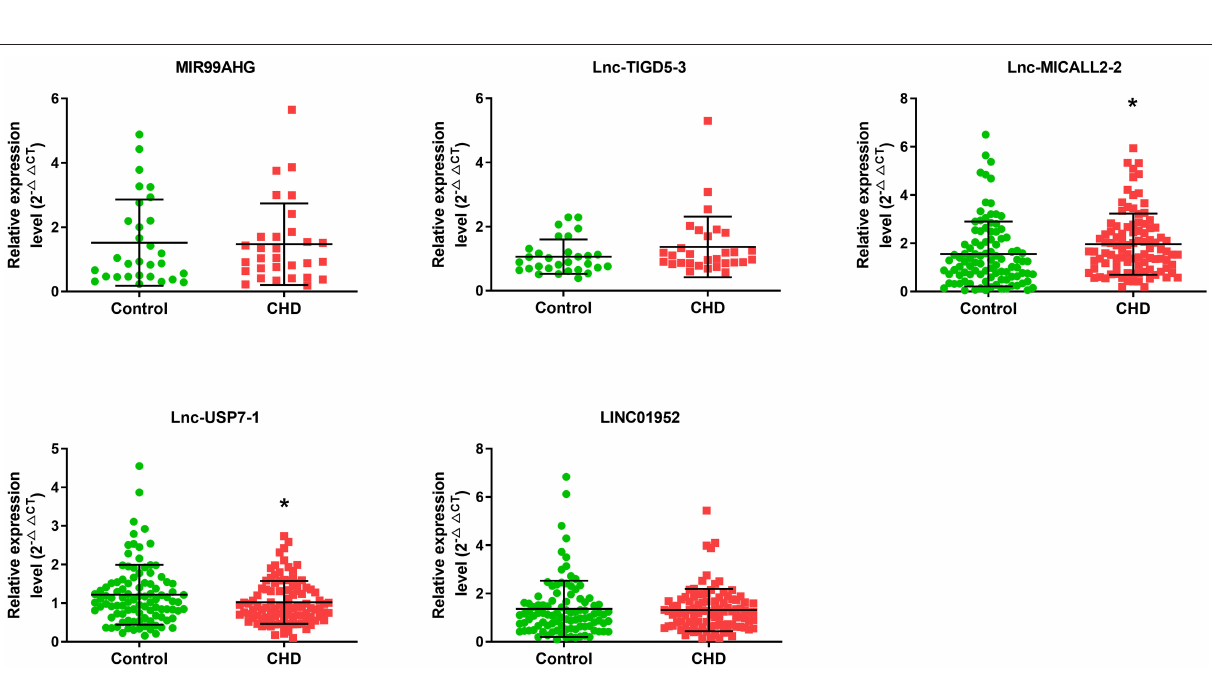
pool of candidates for further study. After filtering the 320 lncRNAs, five were selected for validation due to fold